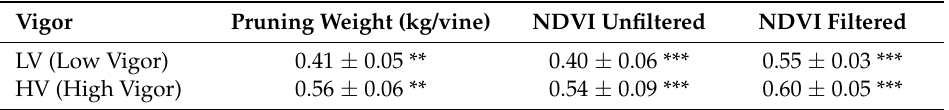
Table 3. Pruning weight, NDVI unfiltered and NDVI filtered calculated for each block.